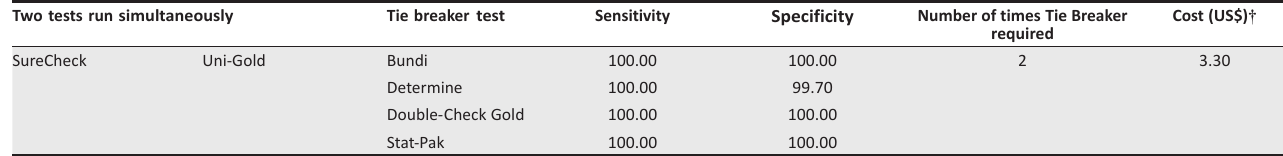
TABLE 1-A3 (Continues...): Parallel